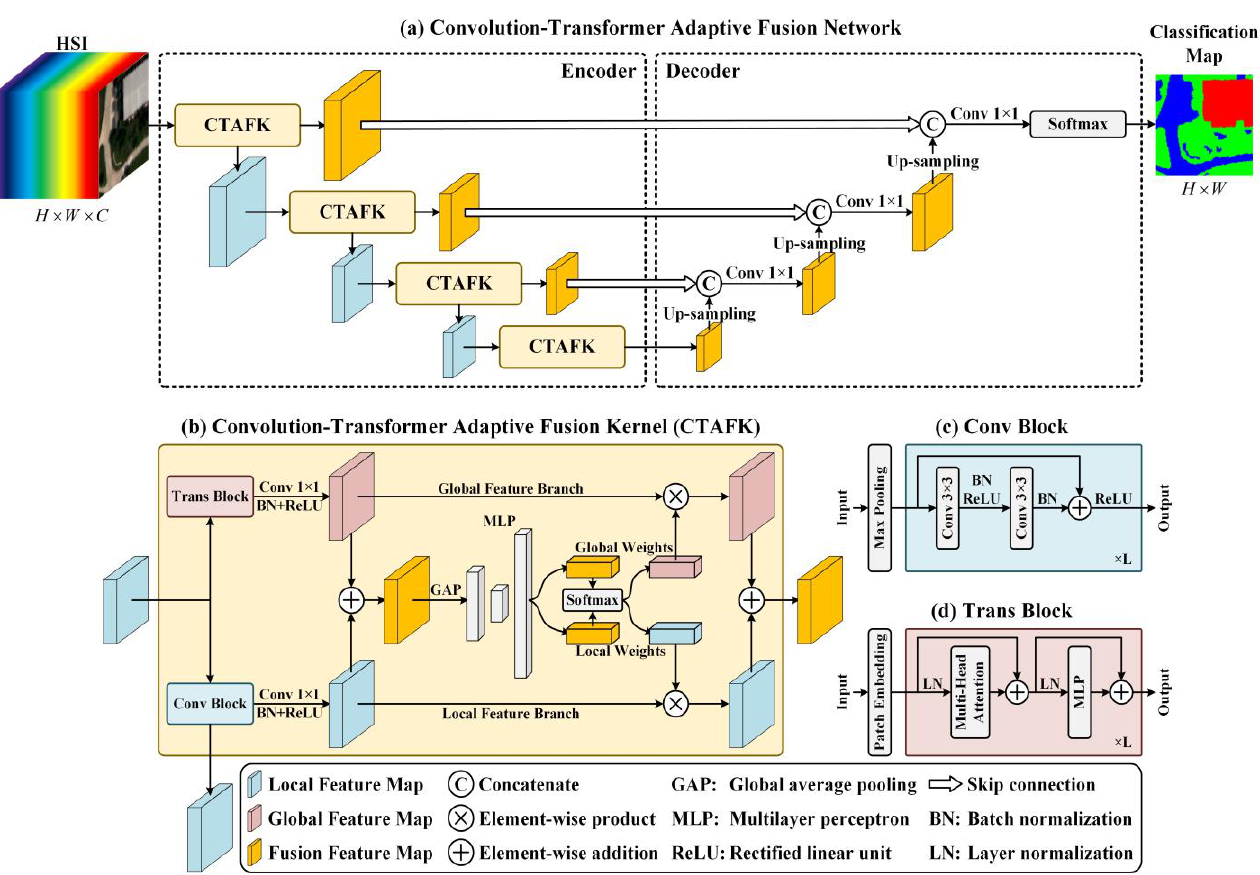
Figure 5. The framework of CTAFNet for HSI classification. Table 4. Output feature size for each